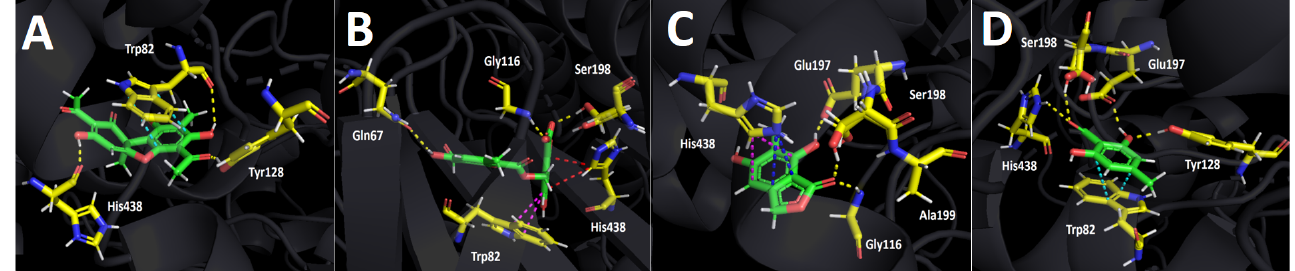
Figure 5. Predicted binding mode and predicted intermolecular interactions of the selected major compounds obtained from H. lugubris extract and the residues of human butyrylcholinesterase ( h BuChE) catalytic site. Yellow dotted lines indicate hydrogen bond interactions, cyan dotted lines represent π – π interactions, magenta dotted lines represent T-shaped interactions, blue dotted lines represent π –cation interactions, and red dotted lines represent salt bridges. ( A ) Usnic acid in the catalytic site; ( B ) barbatolic acid in the catalytic site; ( C ) 5,7-dihidroxy-6-methylphthalide in in the catalytic site; ( D ) atranol in the catalytic site.